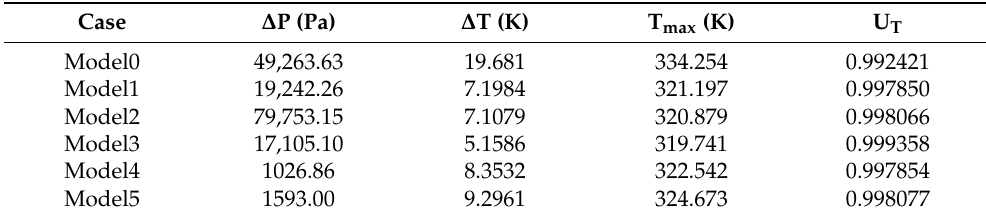
Table 4. Simulation